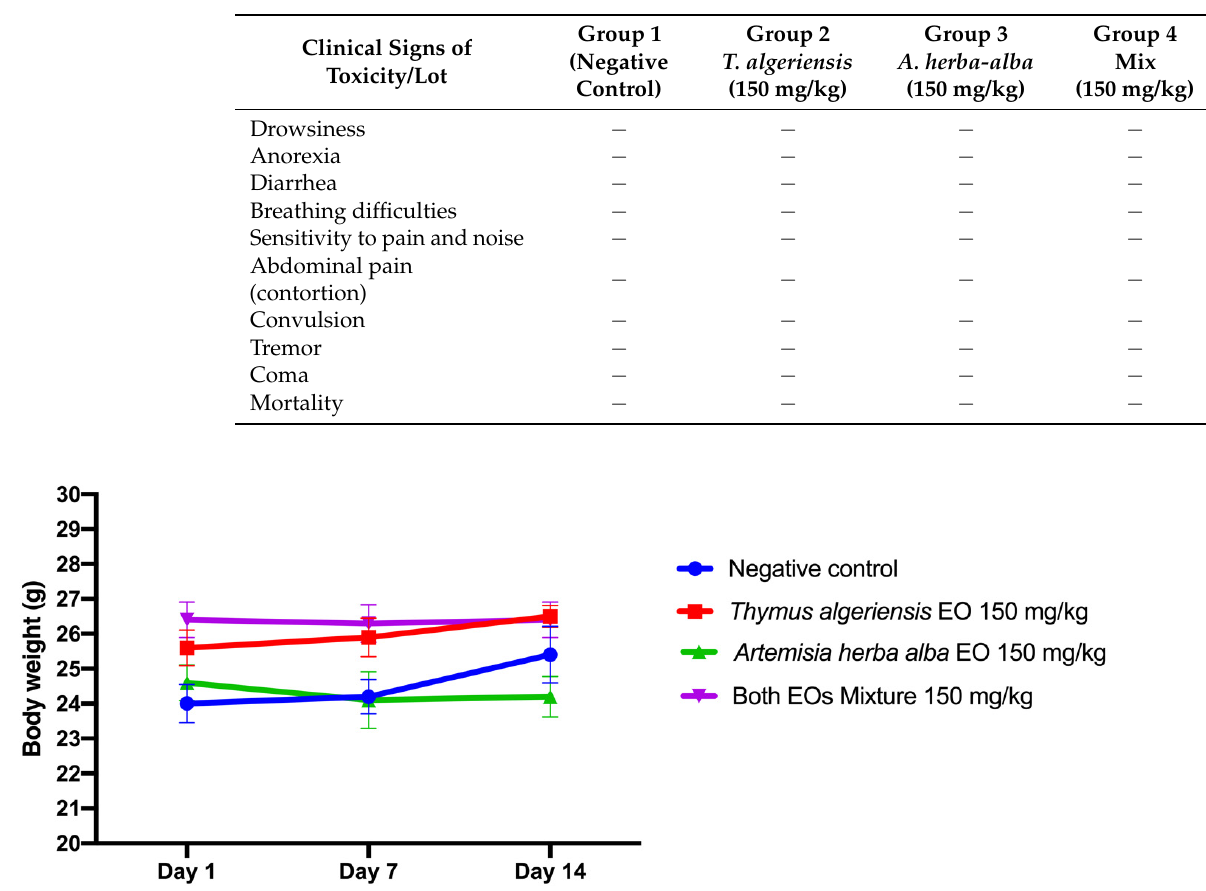
Table 4. Effect of the essential oil mixture administered orally on the weight of organs removed from mice after 14 days of